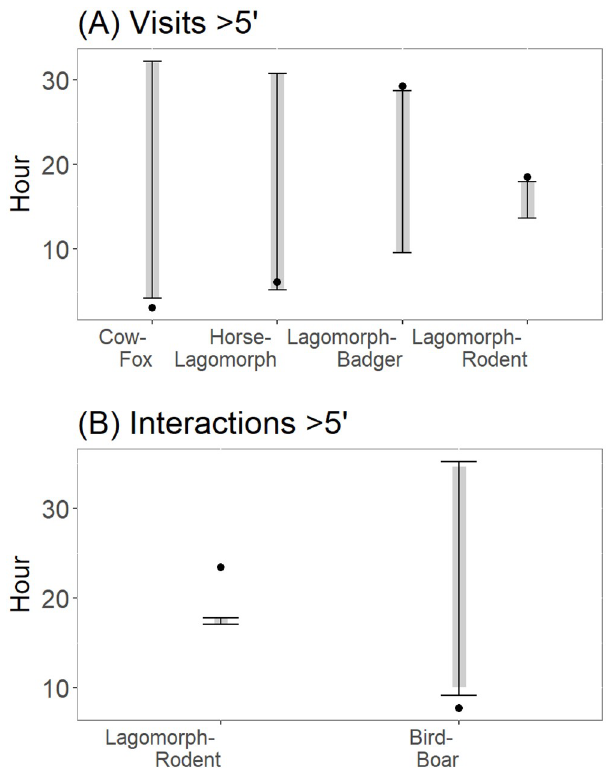
Fig 4. Significant interactions between frugivores of Chamaerops humilis resulting from applying null model 3. Black dots indicate the observed mean time differences (OMTD). Black lines and grey bars represent the expected 95% and 90% intervals of time elapsed between visits, respectively. (A) Interactions derived from the whole set of visit data. (B) Interactions derived from data corresponding to frugivore physical interactions with C . humilis . https://doi.org/10.1371/journal.pone.0240614.g004 Are there differences between observed and expected minimum time elapsed between successive interspecific visits to P . bourgaeana ? (null model 2). When taking into account the whole set of visit data, within a time window higher than 5 minutes, null model 2 showed only one significant response regardless of the spatial independence distance criterion.